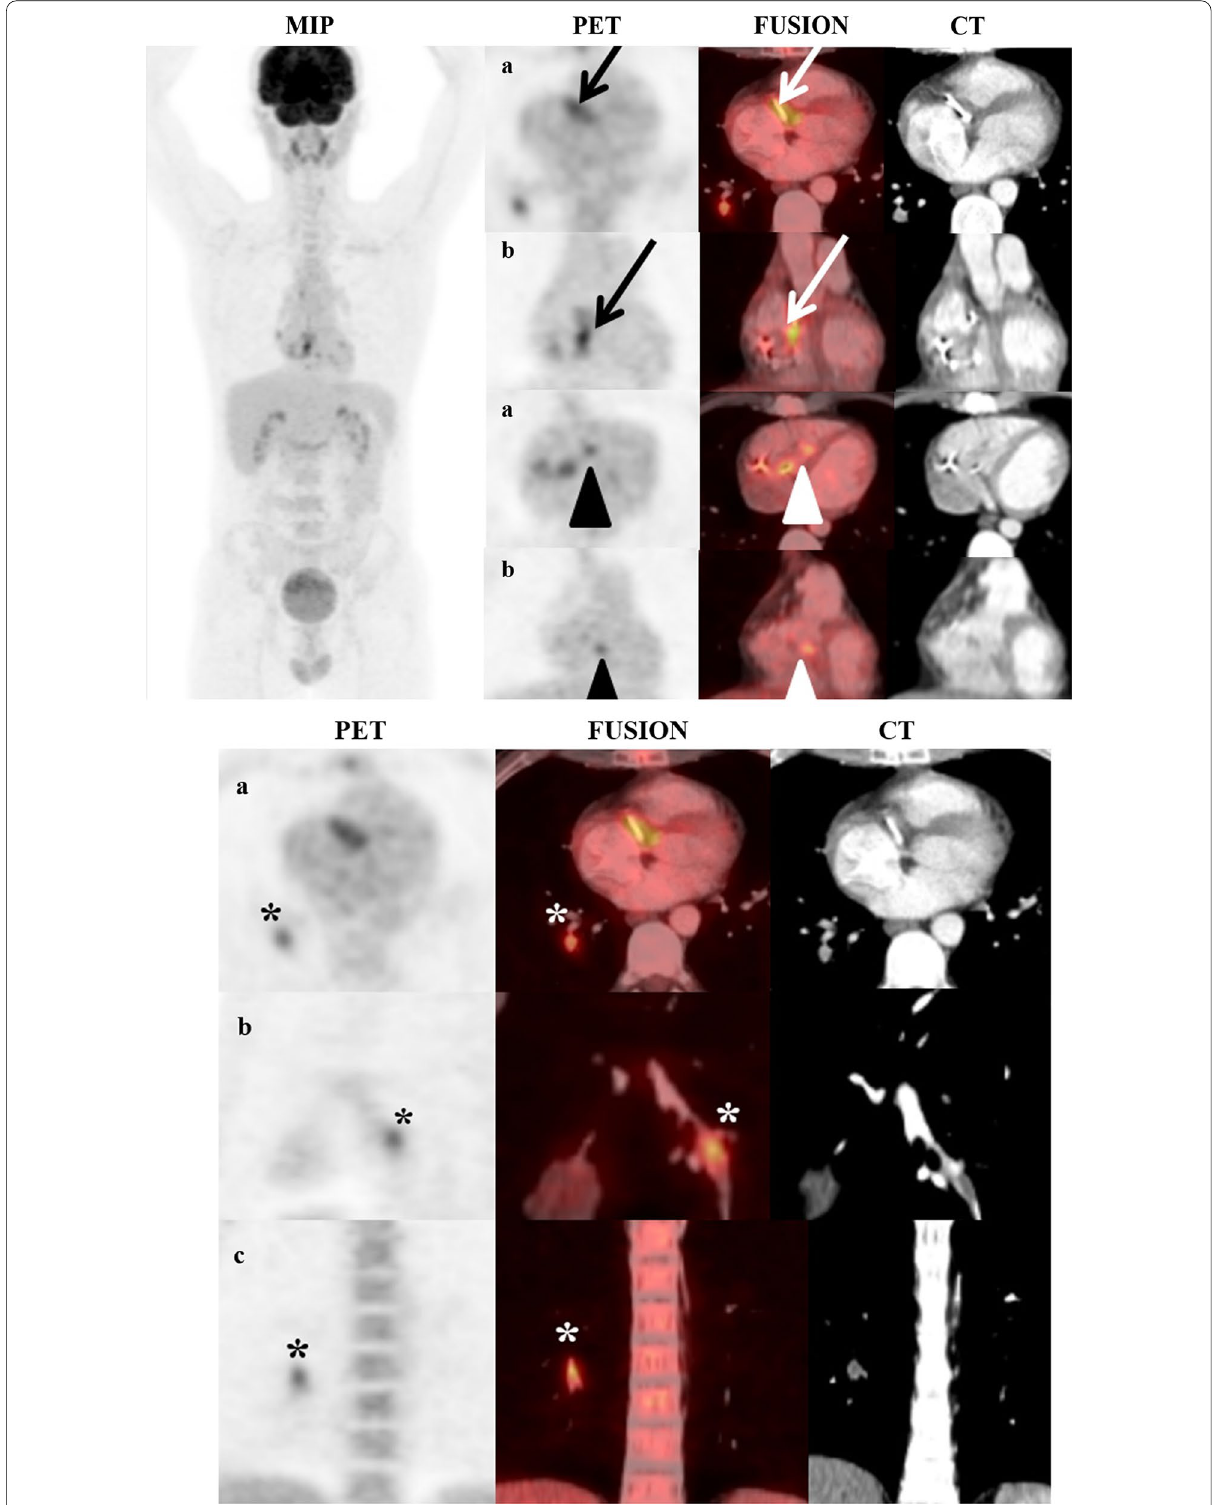
Fig. 1 18 F FDG PET/CT images showing hypermetabolic lesions in the prosthetic tricuspid valve ( arrows ) and papillary muscle of the right ventricle ( arrow heads ). Beside these lesions, PET images revealed a less intensity focal FDG uptake in the pulmonary artery branch of the right lung lower lobe, which was consistent with septic pulmonary emboli ( asterisk ) ( a axial plane, b : coronary plane). MIP: Maximum intensity